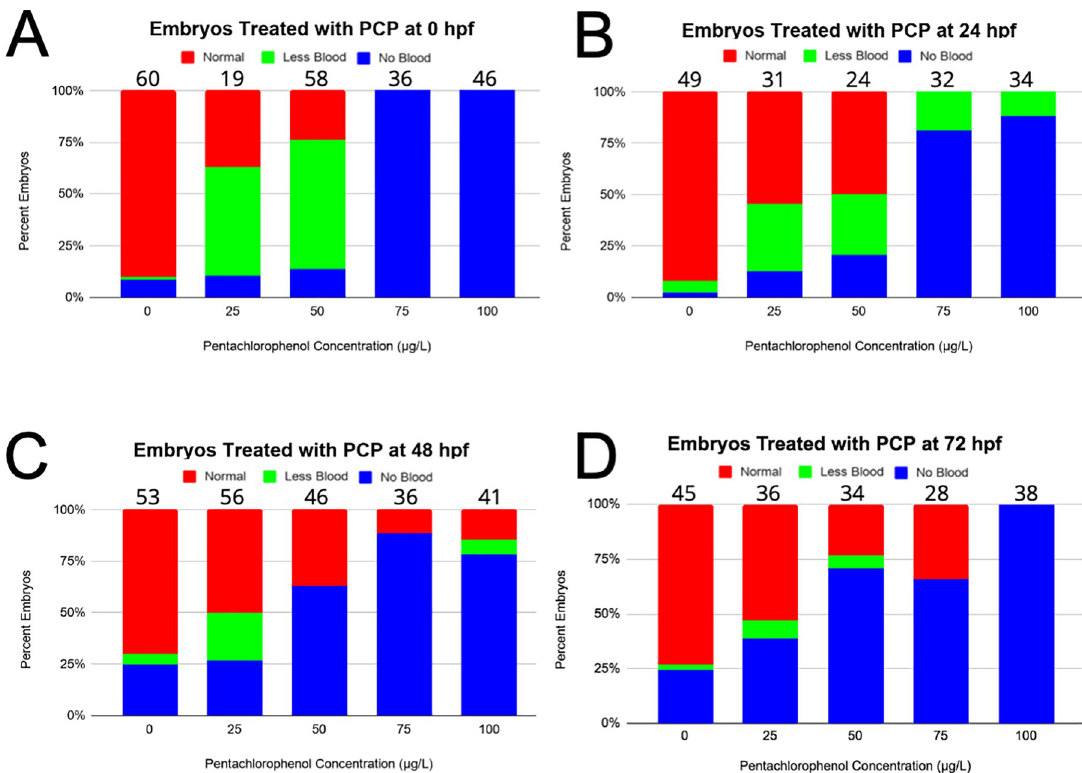
Fig 3. Blood development and circulation is negatively affected by the addition of PCP in the 0, 24, 48, and 72 hpf treatment groups. Blood analysis of zebrafish embryos treated with PCP was analyzed 24 hours after drug application. gata1 :DsRed transgenic zebrafish and fluorescent microscopy were used to observe blood circulation. Blood development in embryos treated at 0 (A), 24 (B), 48 (C), and 72 (D) hpf. Normal circulation (red), less blood (green), and no blood (blue) are all phenotypes highlighted in Fig 2 . Numbers of embryos observed are listed above all